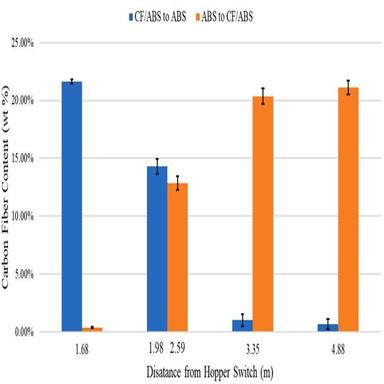
The carbon fiber content at each CIN testing location for both transition directions. Note, the second testing location had different distances, as described above.